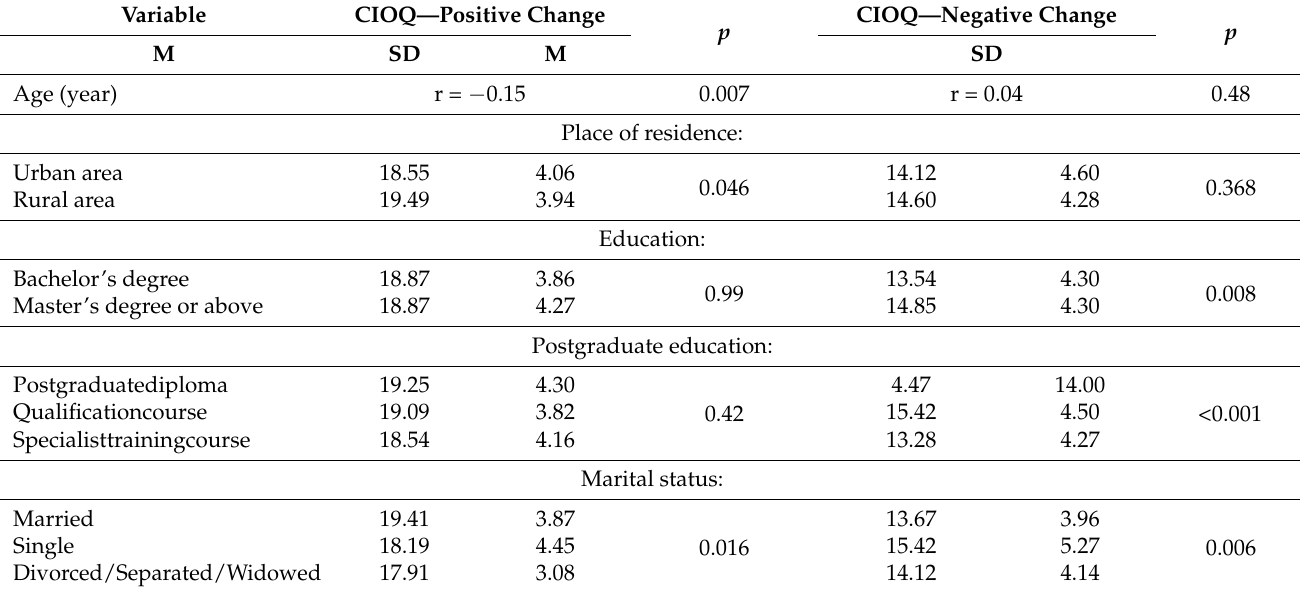
Table 2. Associations between selected sociodemographic variables on the assessment of positive and negative consequences of the COVID-19